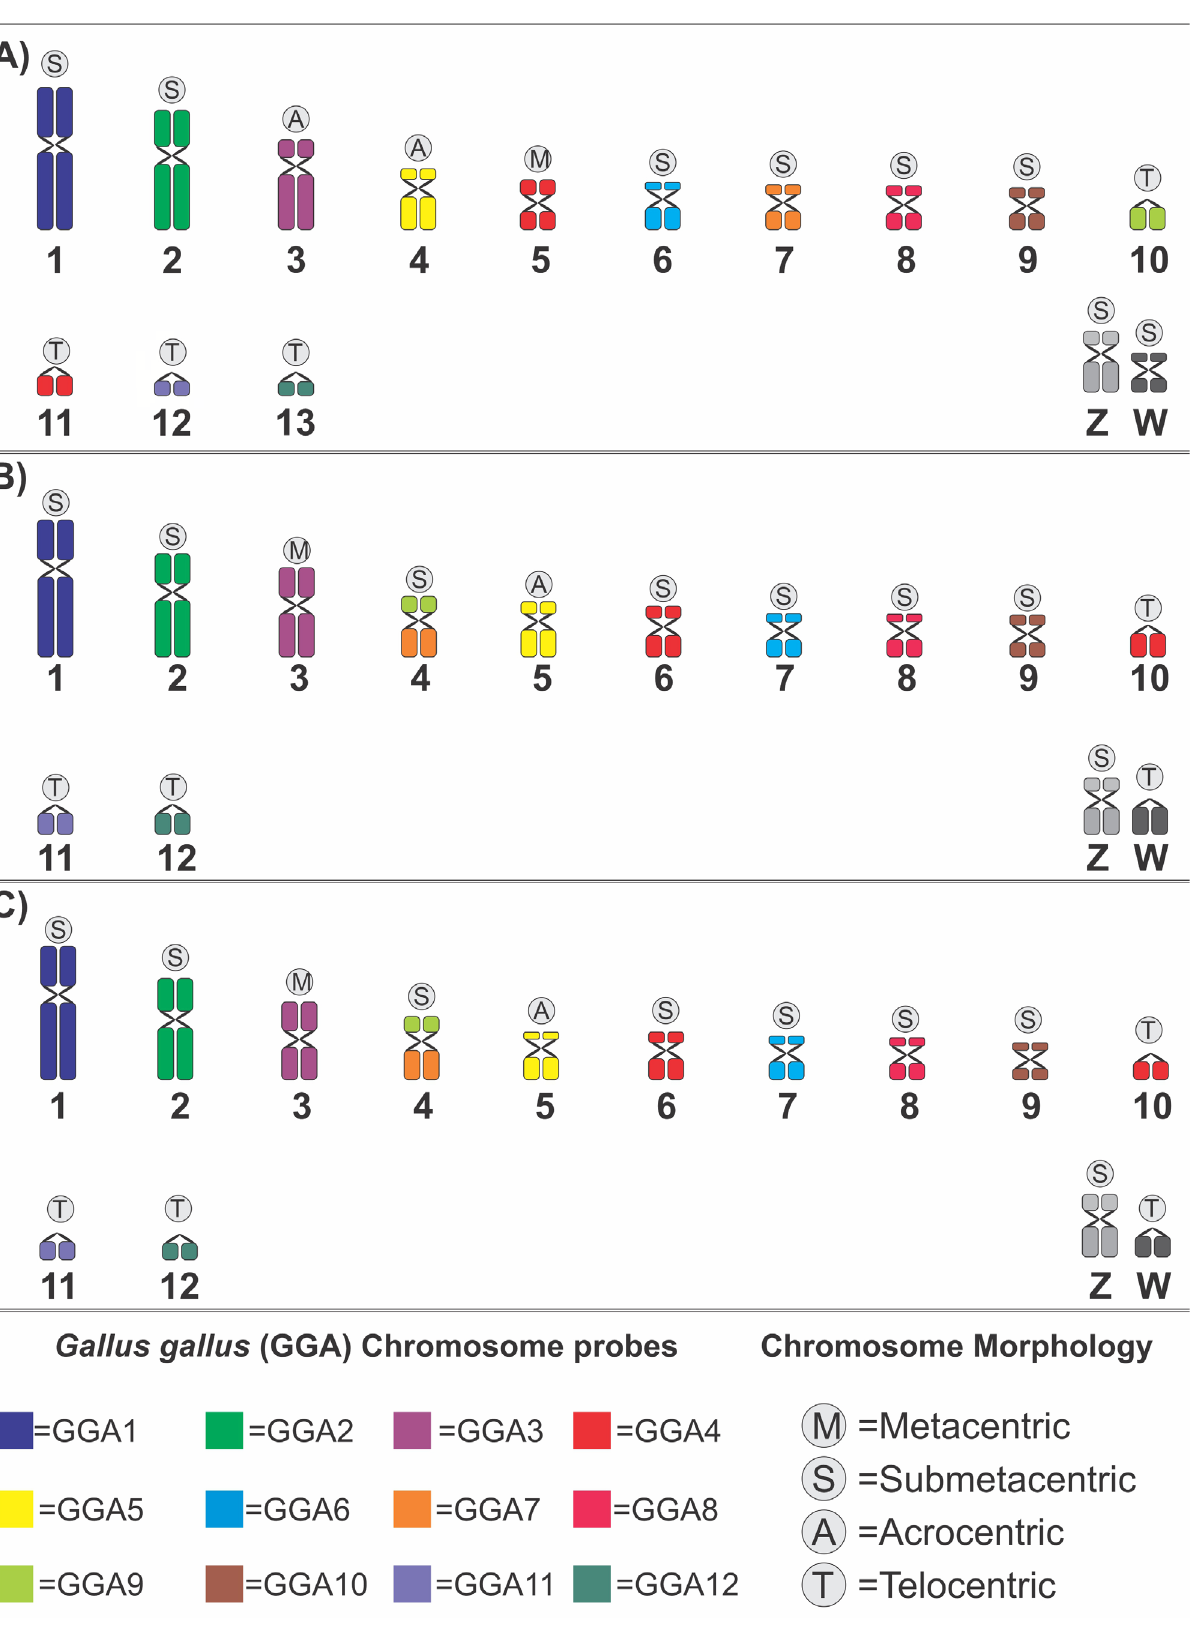
Figure 3 – Comparative ideograms showing the homologies among the macrochromosomes of the hummingbirds Anthracothorax nigricollis (A), Campylopterus largipennis (B), and Hylocharis chrysura (C). This scheme was obtained by Fluorescence in situ Hybridization using the Gallus gallus chromosomal probes (GGA